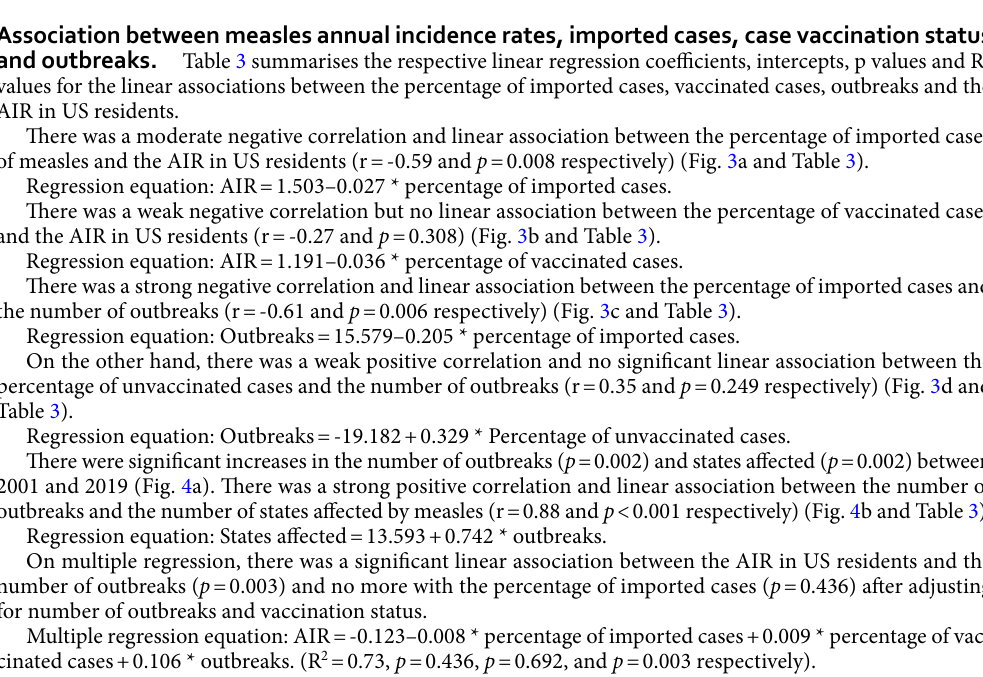
Table 2. Annual measles incidence rates, percentage of imported and vaccinated cases per year in the United States, 2001–2019. NR–Not